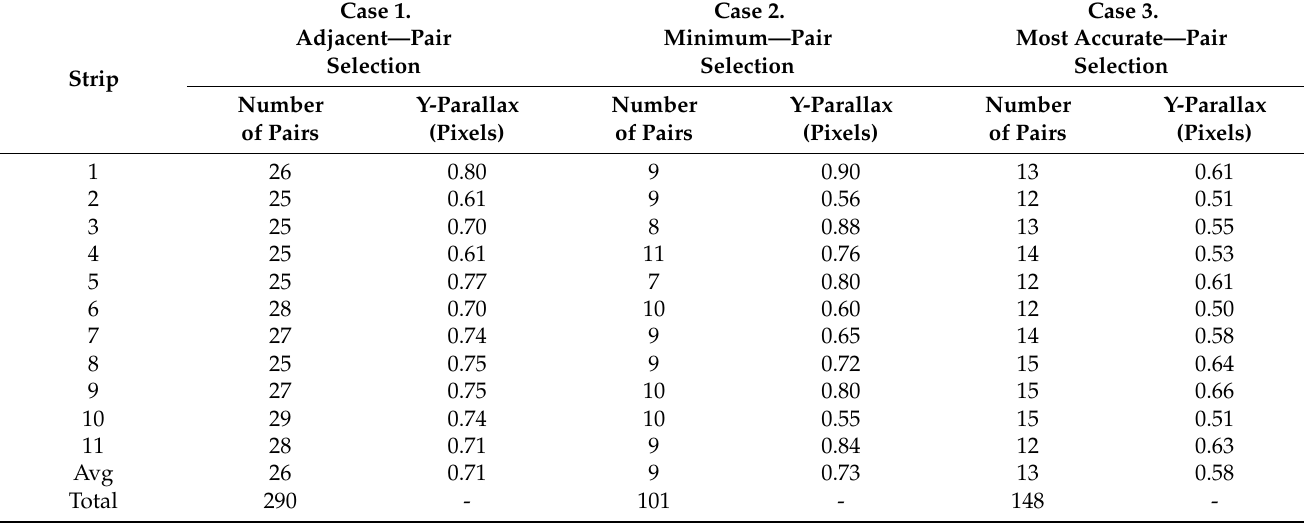
Table 3. Results of optimal adjacent-, minimum-, and geometric-pair composition for each